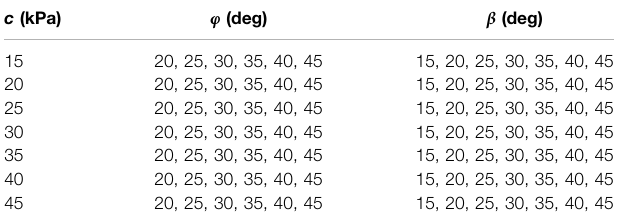
TABLE 1 | Calculation parameters of the MC failure criterion.